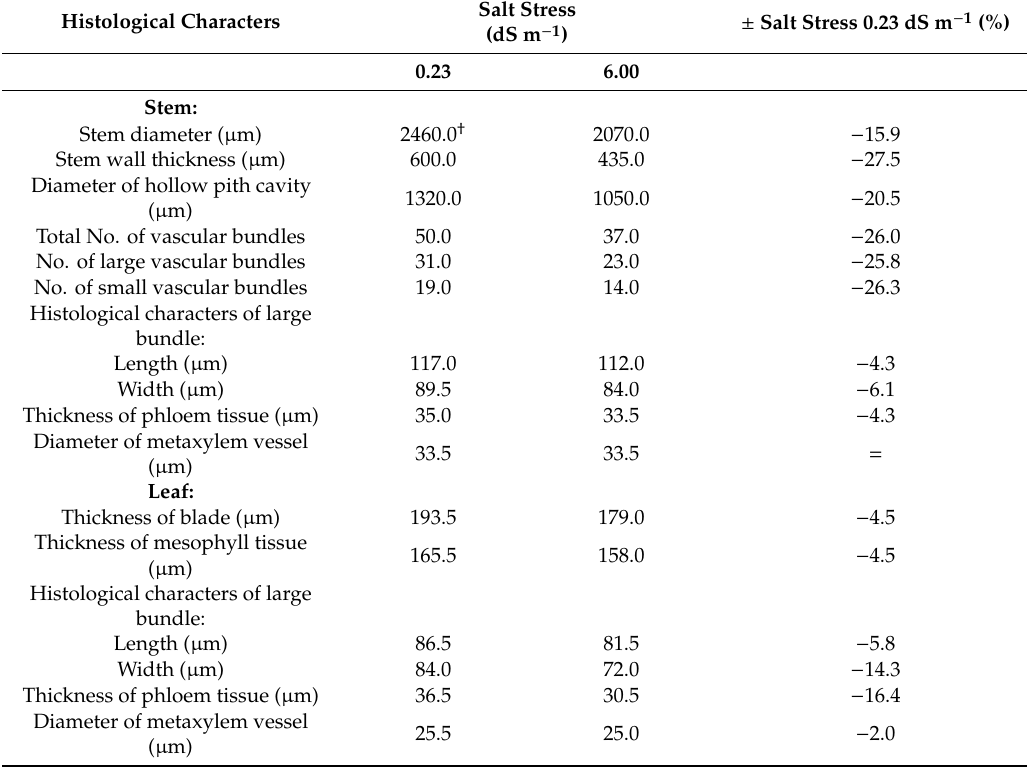
Table 2. Histological characteristics of transverse sections of median portion of the main stems and leaves of wheat plants after subjecting to 0.23 and 6.0 dS m − 1 salt stress for 56